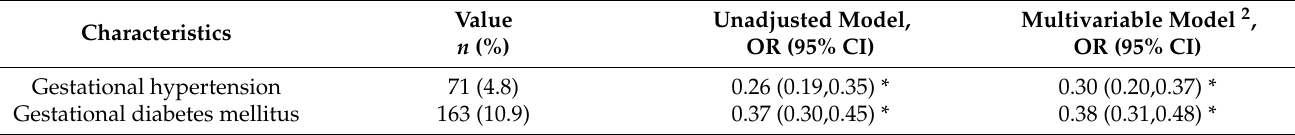
Table 5. Associations between CDGCI-PW scores and risks of pregnancy complications 1 (N = 1489). Characteristics